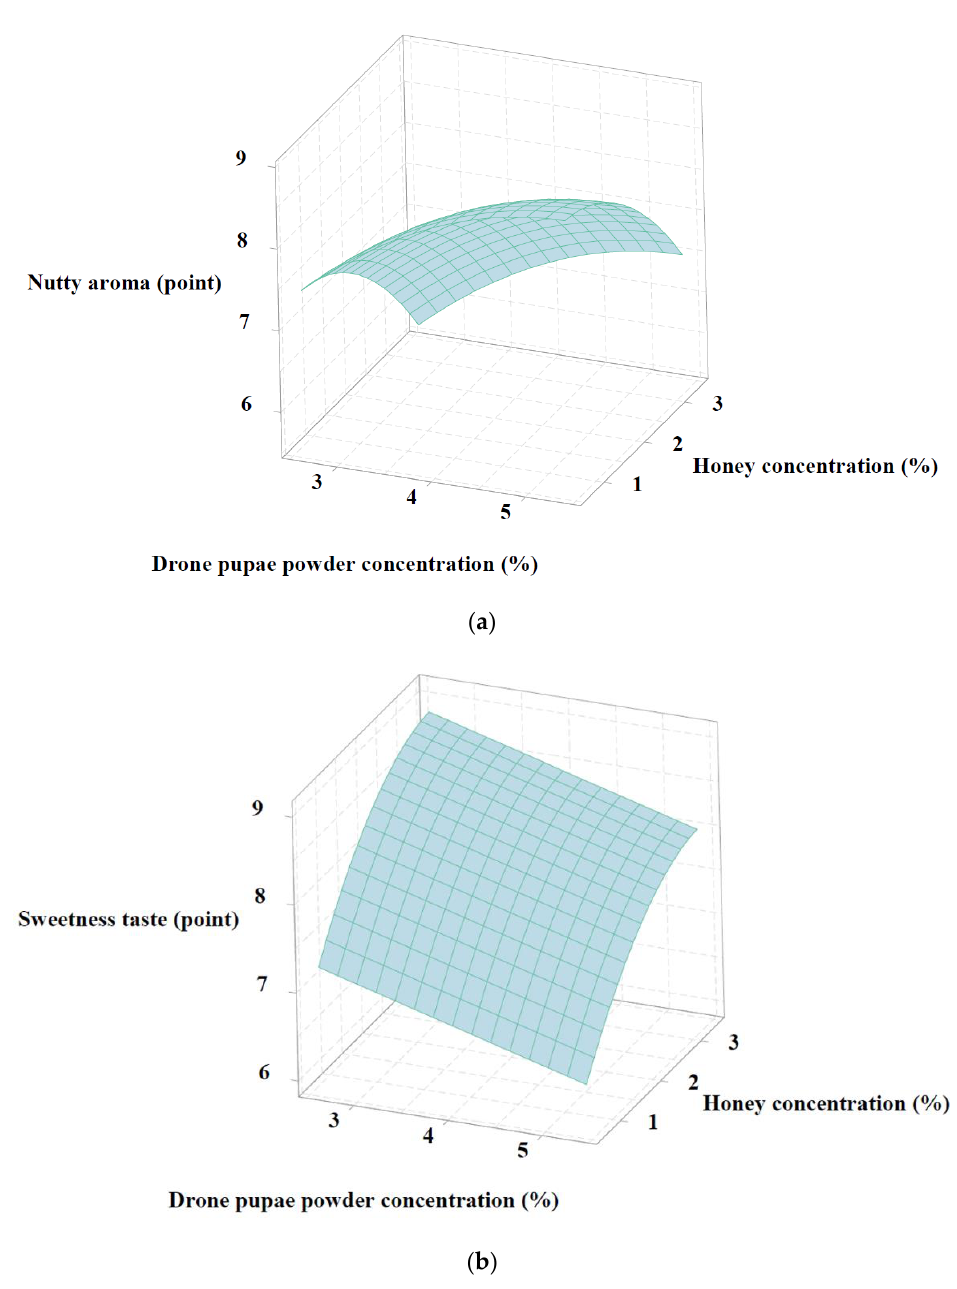
Figure 5. Three-dimensional response surface plots of the puffed-rice snack with respect to drone pupae powder and honey concentrations: ( a ) Nutty aroma; ( b ) Sweetness